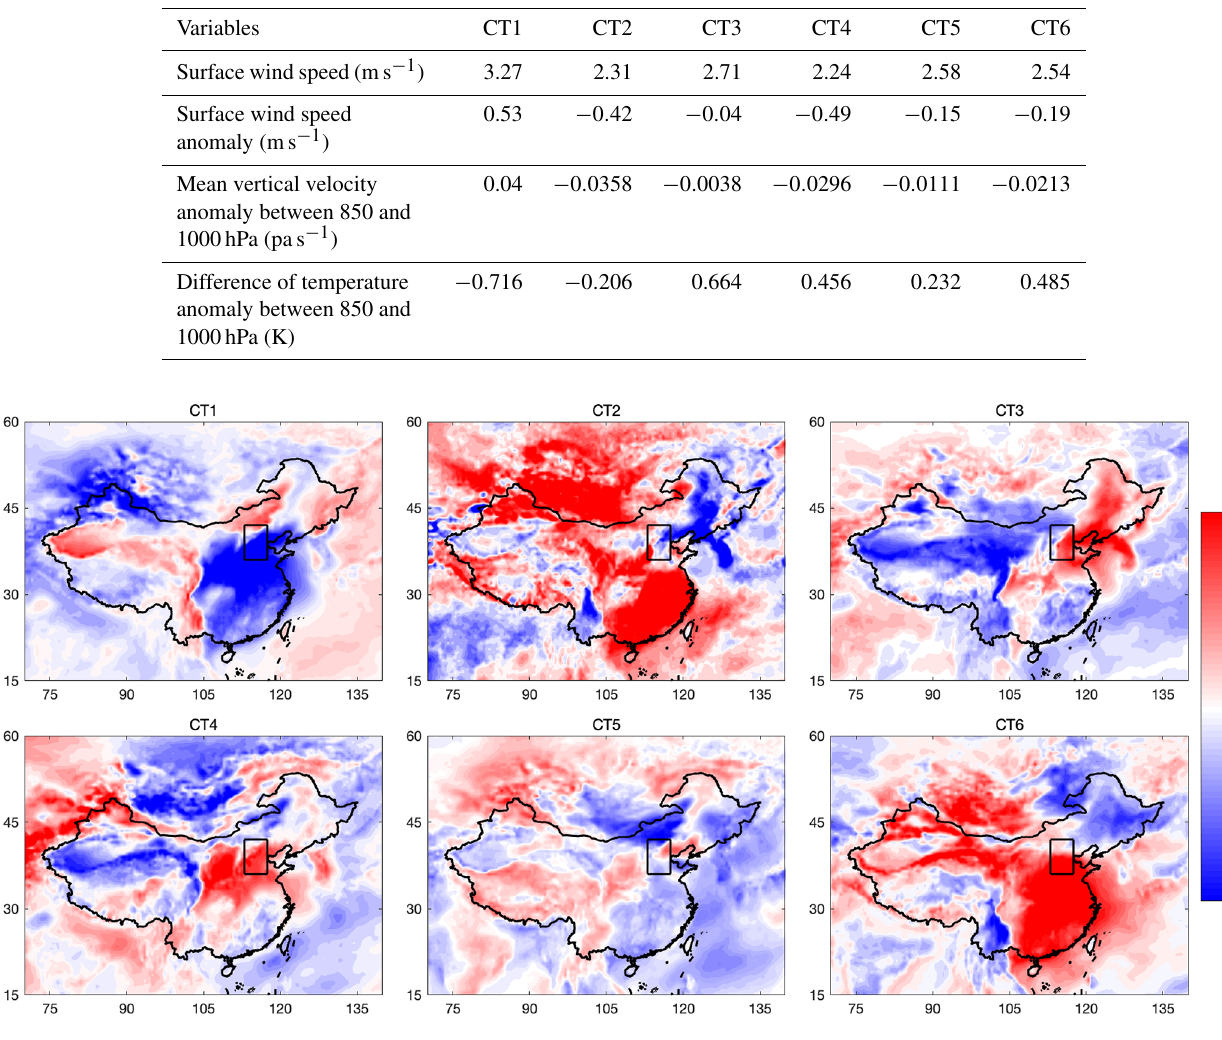
Figure 4. The distribution of relative humidity in each circulation type (unit: %). The anomaly values are with respect to the 1980–2010